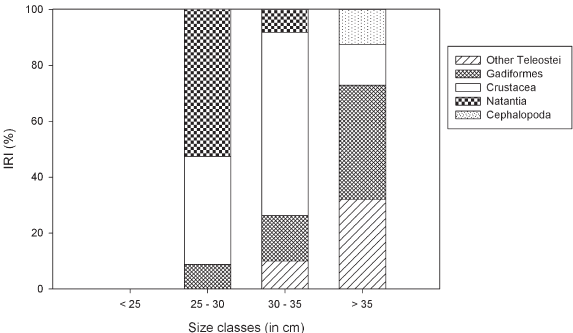
Fig . 3. – Index of relative importance (%IRI) of prey items in re- lation to the size classes Etmopterus pusillus . Data from the two fishing gears combined. Cephalopoda includes all unidentified cephalopods except for those from the Ommastrephidae and Se- piolidade families. Crustacea includes all unidentified crustaceans except for Natantia. (Number of specimens with TL ≤ 25 cm=96; 26-30 cm=101; 31-35 cm=89; and >35 cm=157).